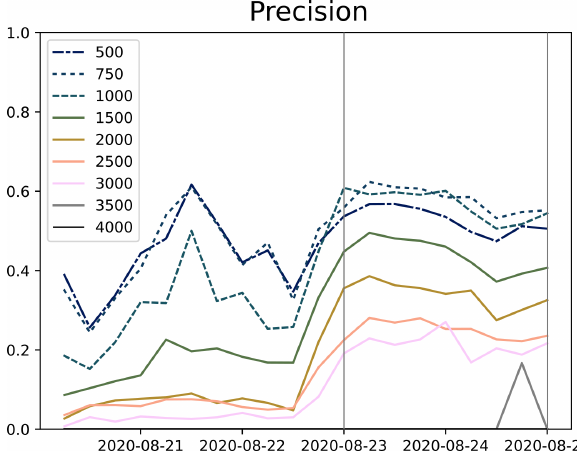
Figure 7. Precision over time for each flight altitude. Altitudes of 500 m, 750 m and 1000 m are presented as dash-dotted, dotted, and dashed, respectively, to aid visual separation. The precision for 4000 m is undefined (0/0) throughout the time series. The colours correspond to the colour bar and the two grey lines correspond to the two epochs shown in Figure 10.